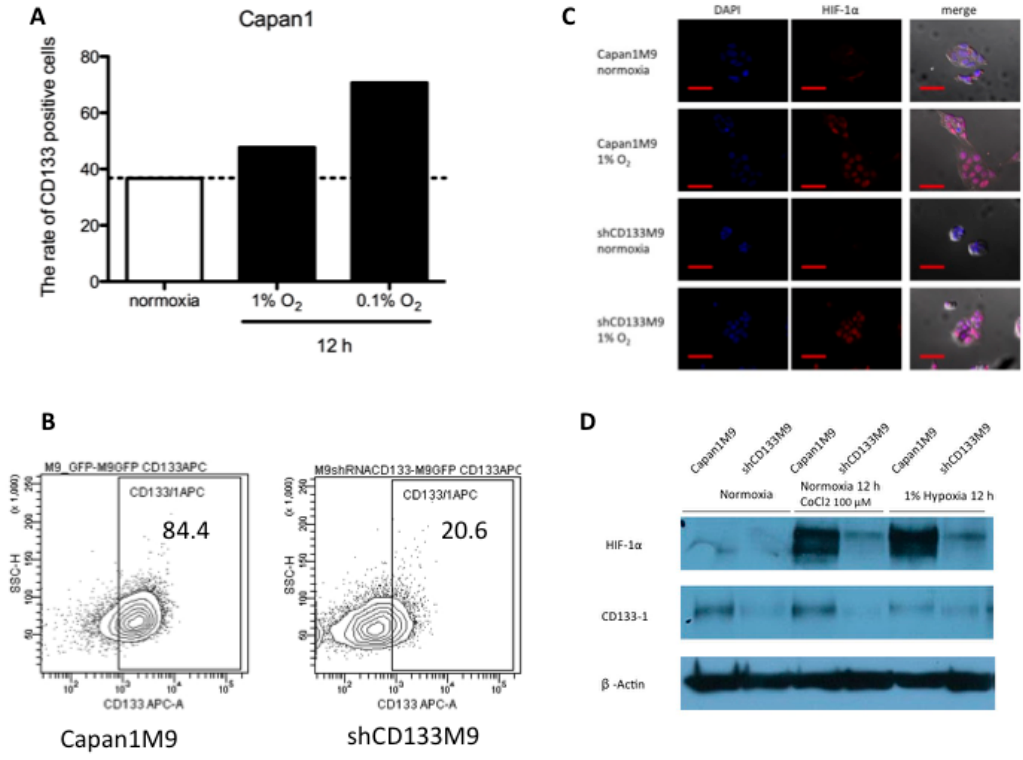
Figure 1. CD133 + cells obtained tolerance to hypoxia. ( A ) Flow cytometric analysis showed an increase of the rate of CD133 + cells under 1% hypoxia and 0.1% hypoxia; ( B ) Capan1M9 cells showed 84.4% CD133 expression and shCD133M9 cells showed only 20.6% CD133 positive rate by flow cytometric analysis; ( C ) Fluorescent immunostaining showed that hypoxia inducible factor (HIF)-1 α expressed in nuclei of Capan1M9 and shCD133M9 under hypoxia. Scale bars show 50 mm as a red bar; ( D ) Western blot analysis proved RNAi methods effectively down-regulated CD133 expression and the difference of HIF-1 α expression level.